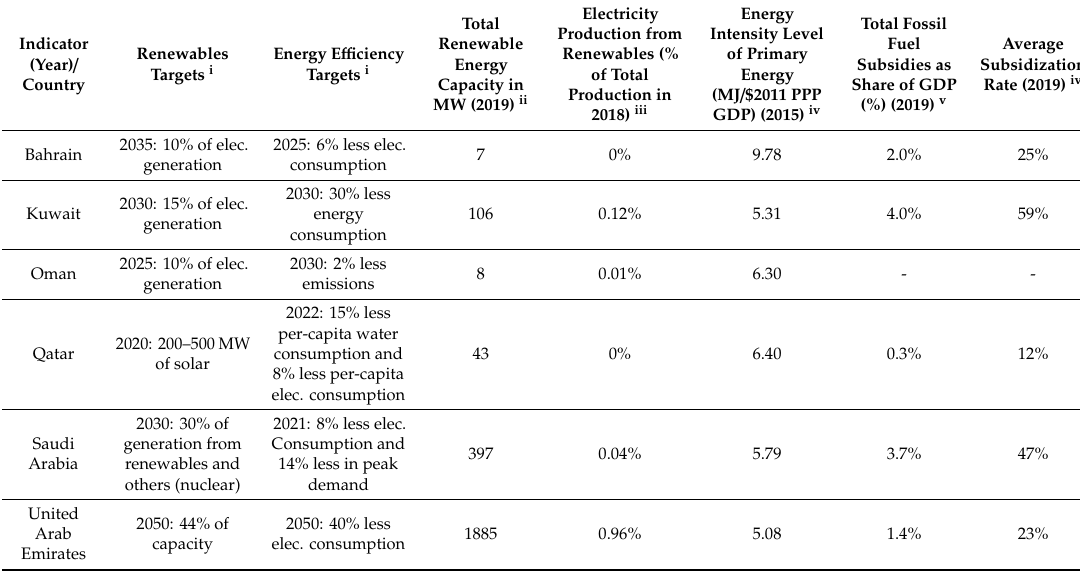
Table 2. Summary of key energy indicators for Gulf Cooperation Council (GCC)